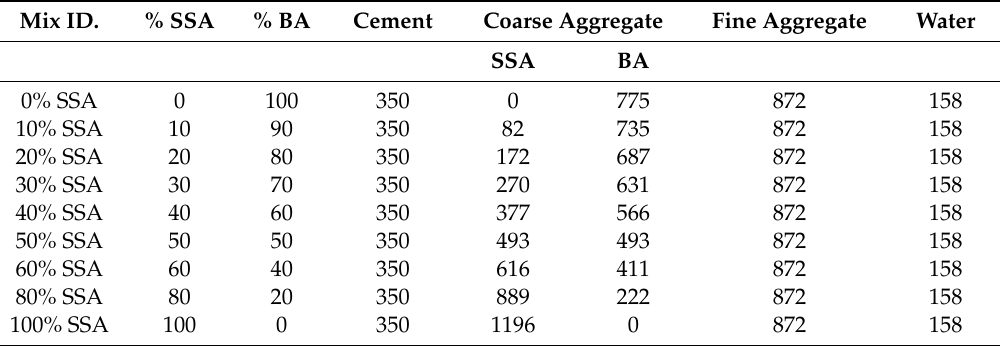
Table 3. Mixture proportion of concrete mixes (kg / m 3